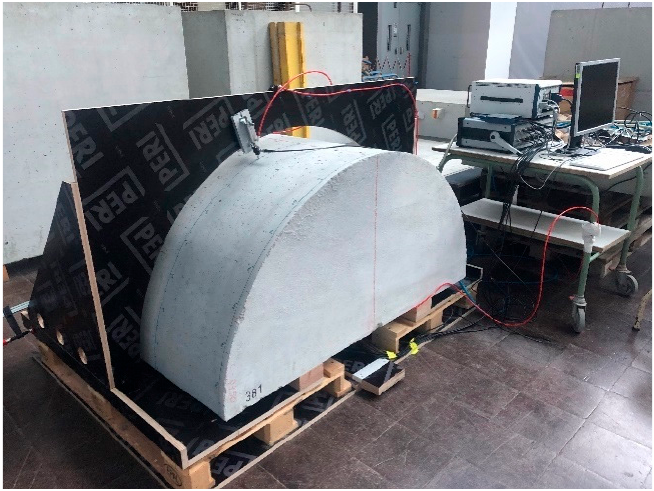
Figure 21. Measurement setup for directivity measurement for third generation probe on concrete half cylindrical specimen.